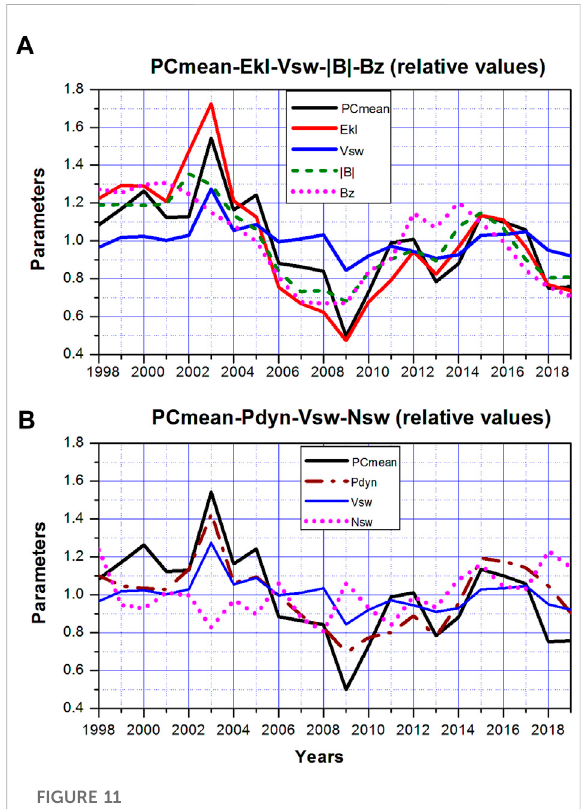
FIGURE 11 Alteration of relative yearly values of E KL , Vsw, Bz, |B| (A) and Pdyn , Vsw , Nsw (B) along with variation PCmean over a period of 1998 – 2019 (Troshichev et al.,